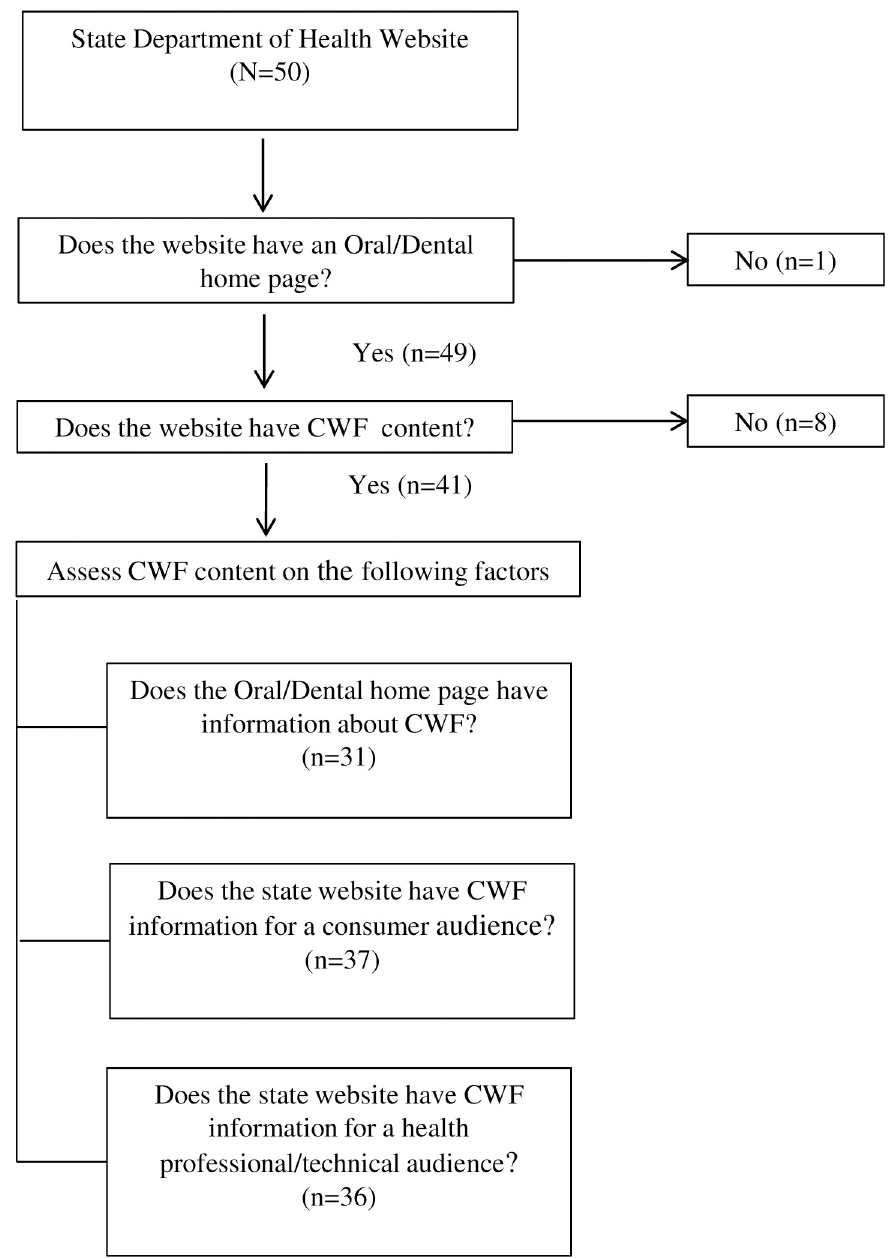
Fig 1. Process for evaluating U.S. state health department websites (N = 50) for content about community water fluoridation, August